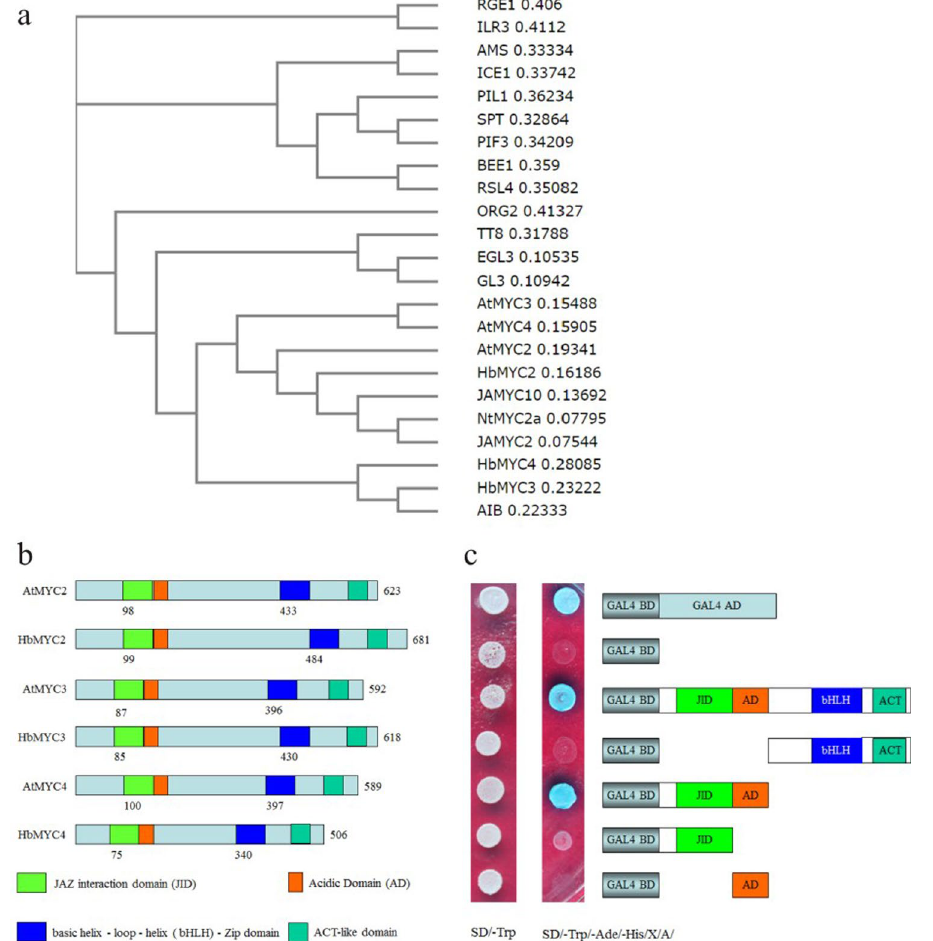
Figure 2. Comparison of the MYC genes of Hevea brasiliensis and other bHLH-type transcription factors. ( a ) Phylogenetic tree of the deduced amino acid sequences of HbMYCs and other plant bHLH proteins. The phylogenetic tree was generated based on the alignment of the full-length deduced amino acid sequences of 23 bHLH proteins. Alignment was performed and the phylogenetic tree was constructed by Clustal Omega (http:// www.ebi.ac.uk/Tools/msa/clustalo/), with the default settings. ( b ) Domain comparisons between HbMYCs and AtMYCs, JAZ-interacting domains (JIDs), acidic domains (ADs), basic helix-loop-helix (bHLH)-zip domains and ACT-like domains were included. C . Transcriptional activity analysis of the different domains of HbMYC3 proteins. Full-length or attenuated fragments of HbMYC3 were inserted into a pGBKT7 vector, after which the vectors were transferred into Y2HGold yeast strains and then plated on SD/-Trp/-Ade/-His/X- α -gal/AbA